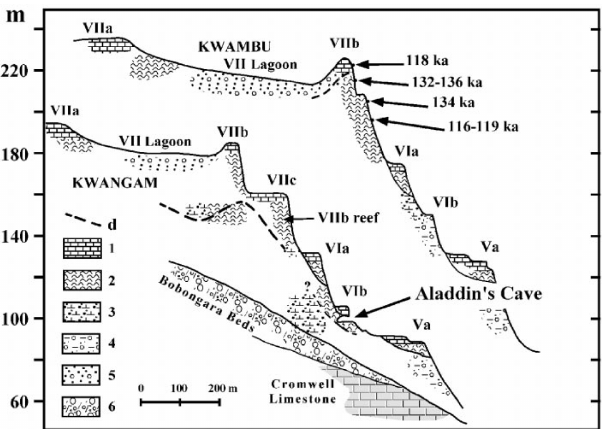
Figure 31. A profile of coral terraces V to VII, including Aladdin’s Cave at the base of reef VIb 870 at west Kwangam and the equiv- alent reefs at Kwambu. The horizontal scale for both sections is 1 : 15000, which was calculated from air photographs; the vertical scale for Kwambu was calculated from a theodolite survey, and the vertical scale for Kwangam was calculated from a calibrated digital altimeter (from Esat et al.,